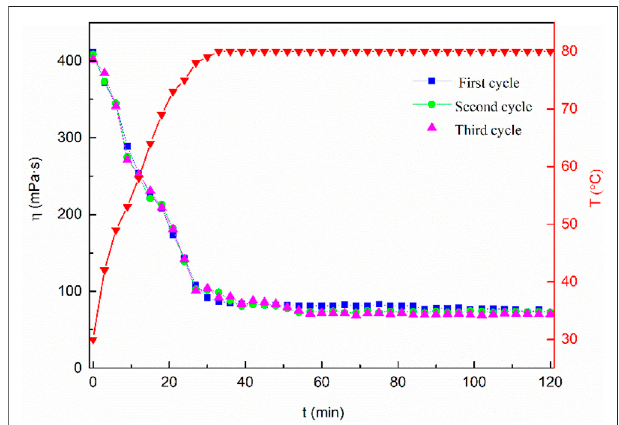
FIGURE 13 | Change of viscosity of the MSA/CTAB cycled system versus time showing the heat and shear resistance of the